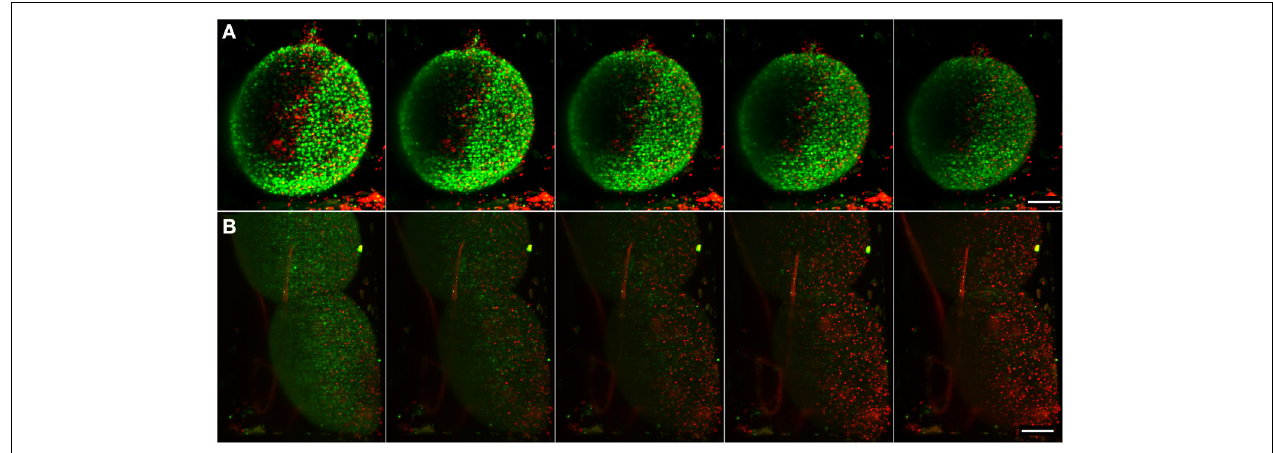
FIGURE 6 | Imaging of apoptosis in differentiated neural aggregates. Maximum intensity projection of five different time points, acquired every 150min, of samples with NucView 488 (green) and MitoView 633 (red). (A) Control sample with only